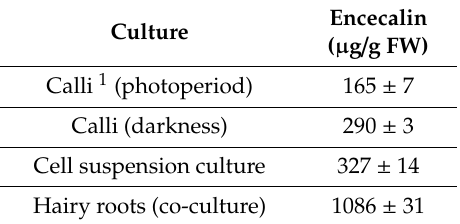
Table 2. Amount of encecalin quantified in Helianthella quinquenervis cultures. Culture